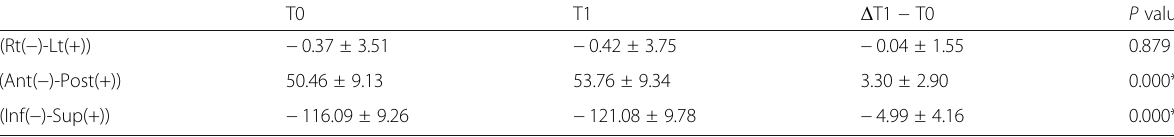
Table 3 Displacement of hyoid bone in X -, Y -, and Z -axes before and after surgery (mm) T0 T1 Δ T1 − T0 P value X(Rt( − )-Lt(+)) − 0.37 ± 3.51 − 0.42 ± 3.75 − 0.04 ± 1.55 0.879 Y(Ant( − )-Post(+)) 50.46 ± 9.13 Z(Inf( − )-Sup(+)) − 116.09 ± 9.26 0.000*** Data are presented as mean ± standard deviation. Paired t tests were performed to determine significant differences in displacement of the hyoid bone in x -, y -, and z -axes between T0 and T1. T0 before surgery, T1 1month after surgery, Rt right, Lt left, Ant anterior, Post posterior, Inf inferior, Sup superior * P < 0.05; ** P < 0.01; *** P <